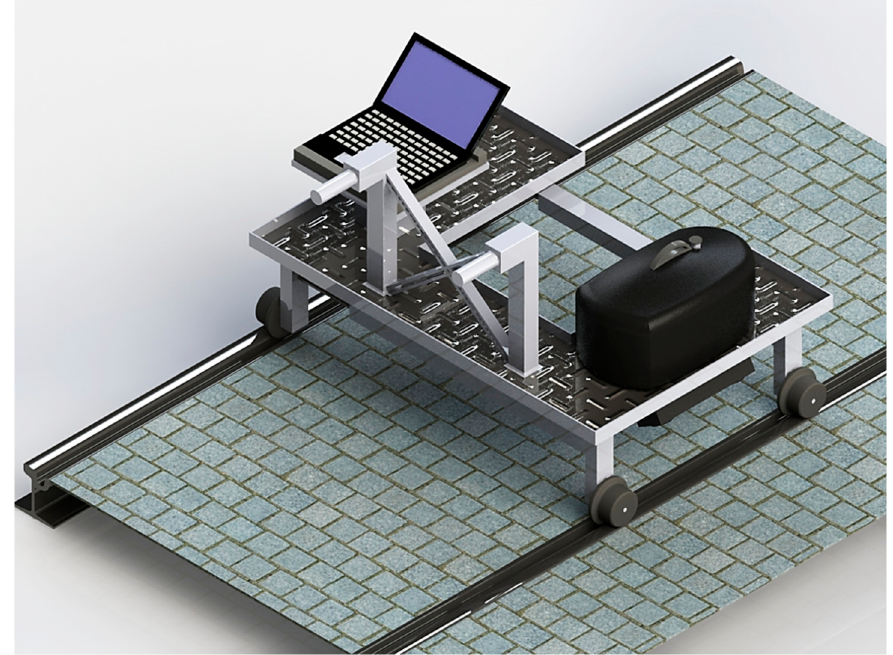
Figure 8. Twin instrumented trolley for complete 3D inspection of tracks.